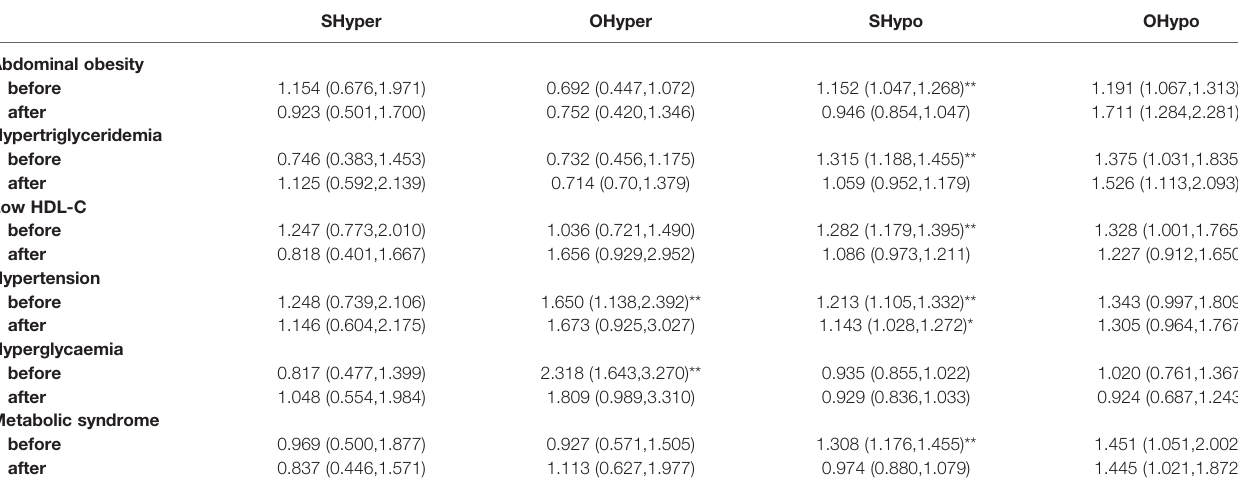
TABLE 5 | Risk of metabolic syndrome associated with thyroid function in women before and after